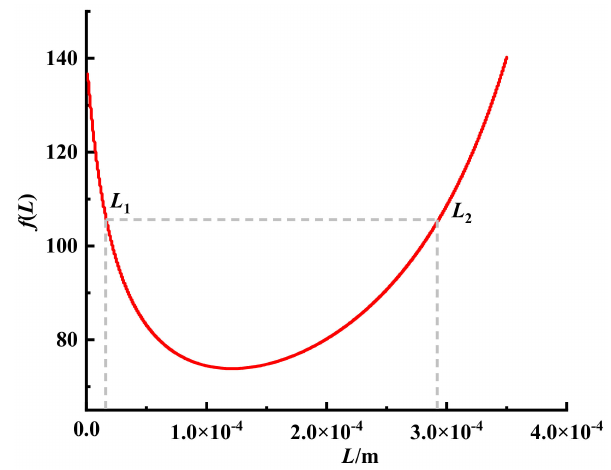
Figure 3. The function f ( L ) varies with the length of the wing crack L.